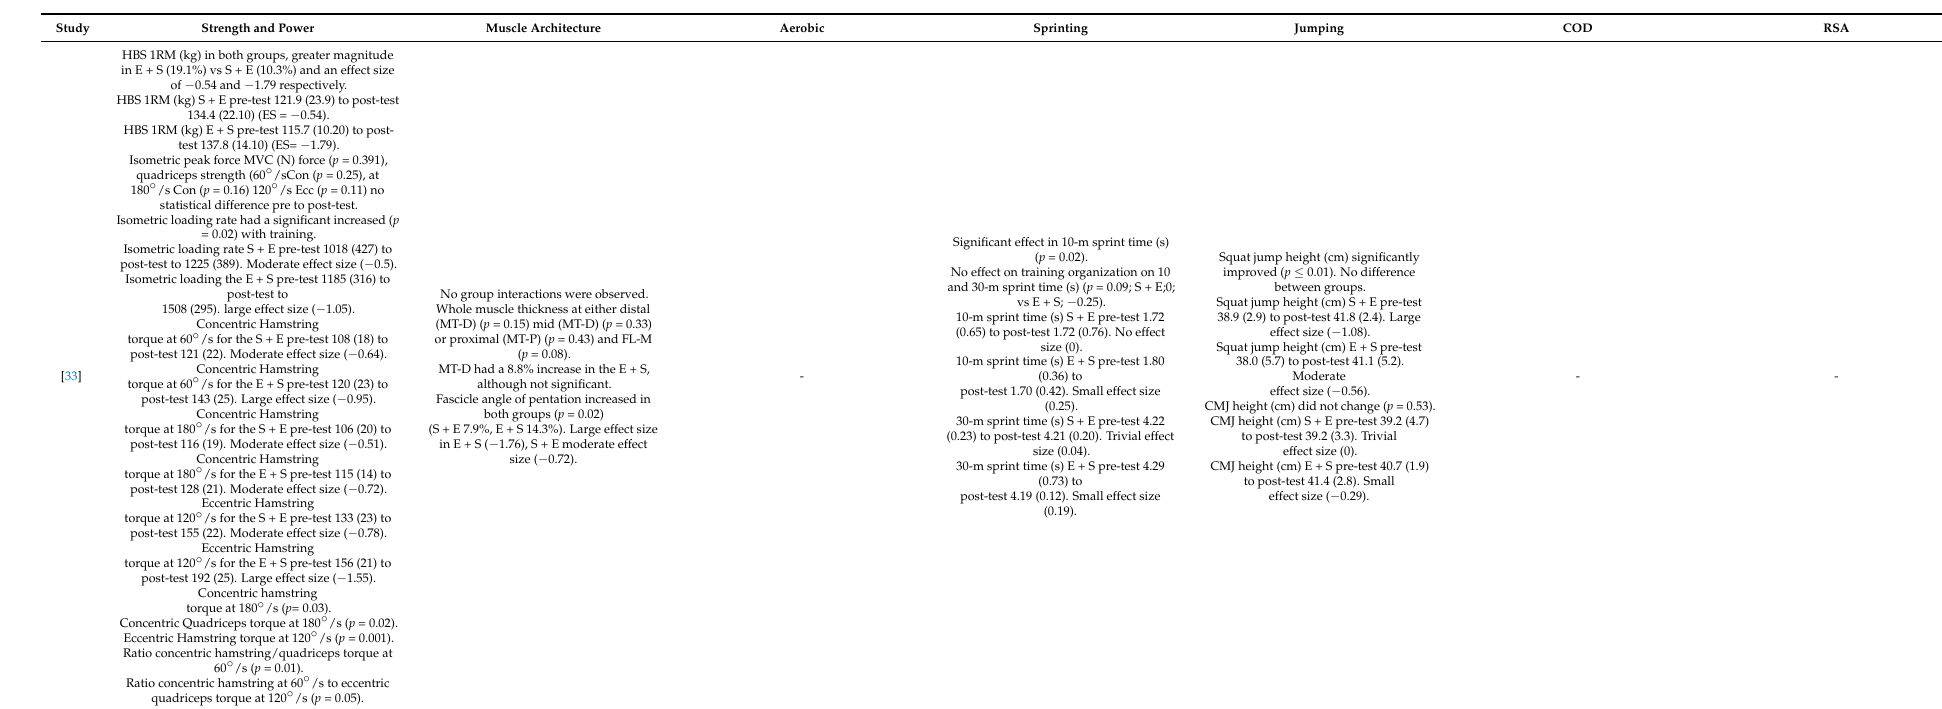
Table 7. Qualitative synthesis and summary measures considering the chronic effects of concurrent training